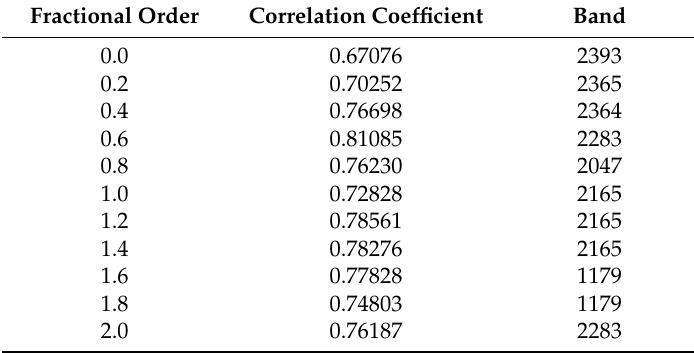
Table 1. Absolute value of maximum correlation coefficient of the 11th-order differential and its corresponding band.